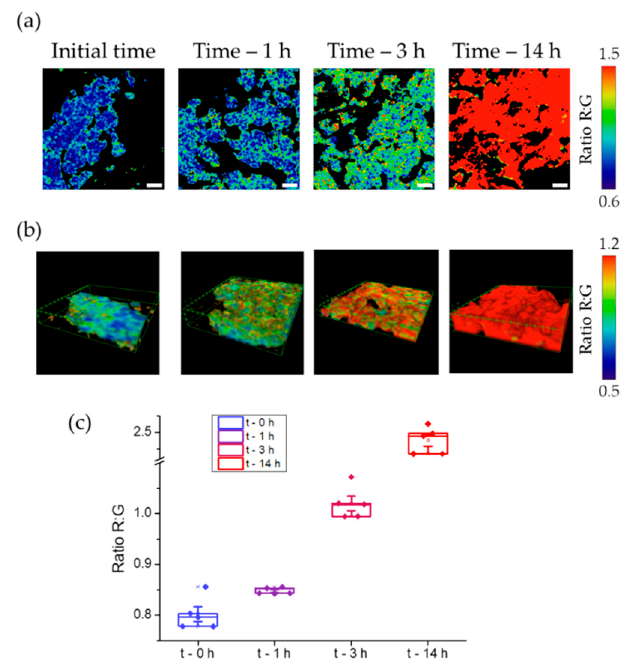
Figure 7. ( a ) Ratiometric images of A-375 tumours after adding DCM-HBU (5 µ M) over time using two-photon microscopy with excitation at 800 nm. Scale bars are 10 µ m. ( b ) 3D ratiometric images of A-375 tumours using two-photon microscopy with excitation at 800 nm. ( c ) Representation of the R:G ratio values from microscopy images. Boxes represent the 25th, 50th, and 75th percentiles. Whiskers represent the SE.